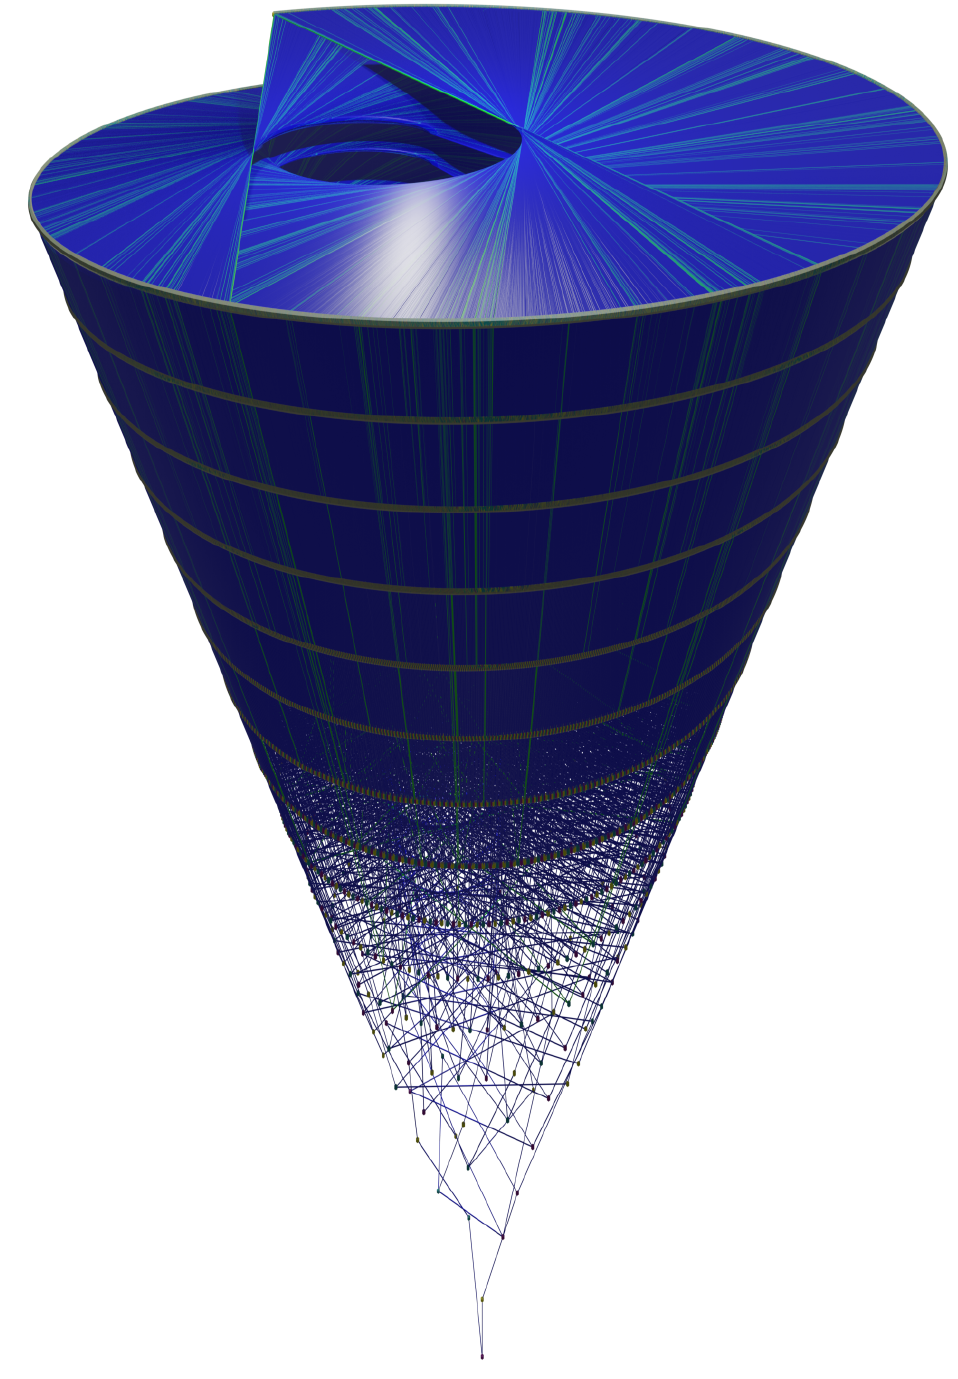
Figure 23. Isometric projection of Figure 22 (code available at [42]). The green lines visible on the sides represent a binary transformation (e.g., operations S, V, or G) and those visible on the top of the cone represent ternary operations (e.g., 3), thus decomposing the correlates (one in base 2 and × one in base 3) of the inflation propensity of the number’s orbit in two dimensions. From this figure, it could be possible to implement faster proof-of-work verification of the Bocart protocol by just scanning the side lines, though this would admit a certain margin of